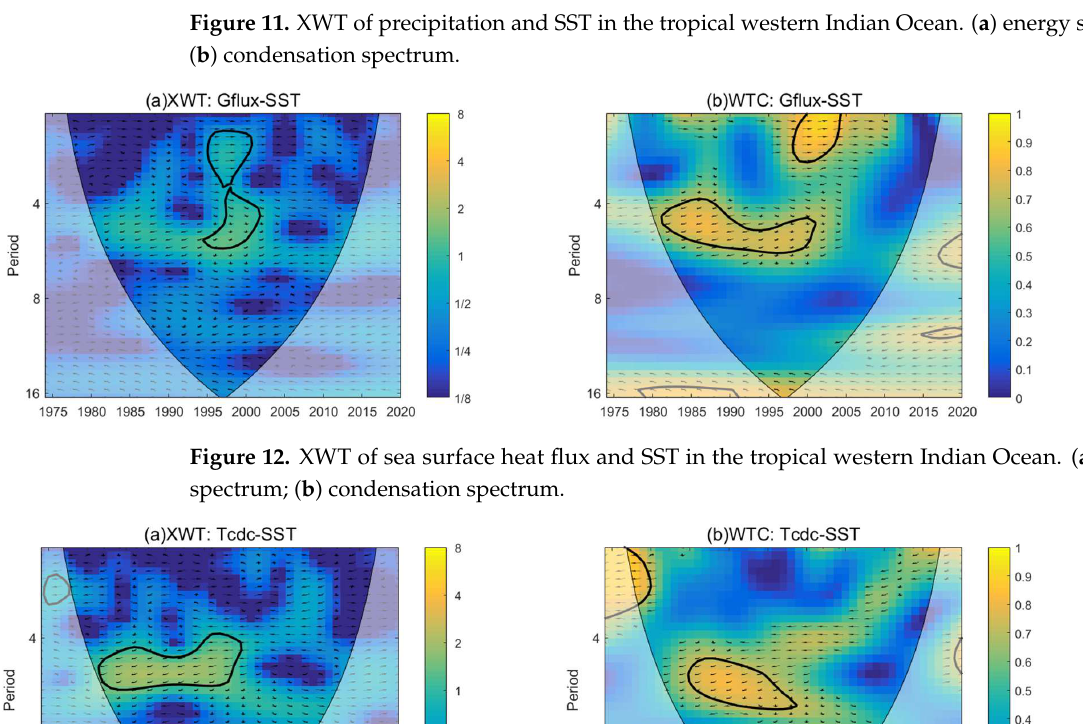
Figure 12. XWT of sea surface heat flux and SST in the tropical western Indian Ocean. ( a ) energy spectrum; ( b ) condensation spectrum.